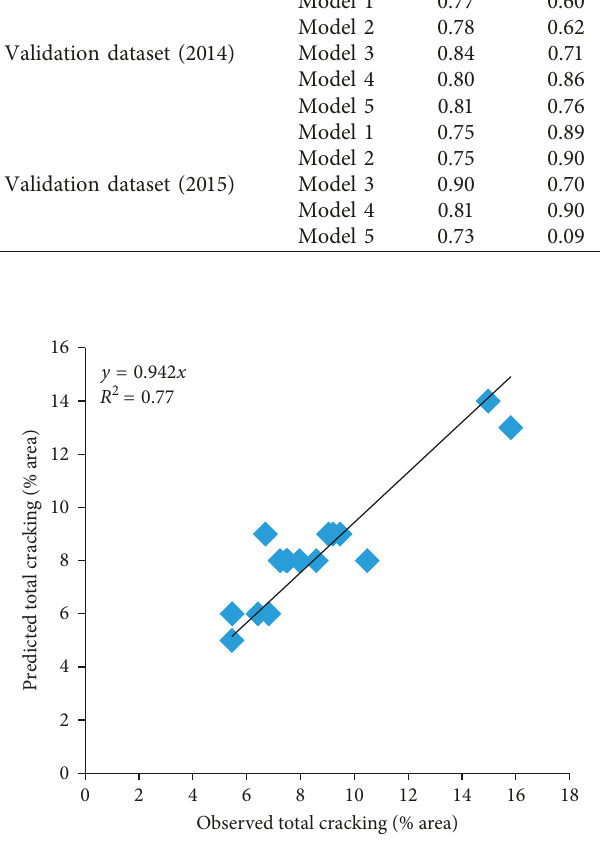
Figure 19: Scatter plot between observed versus predicted total cracking for validation